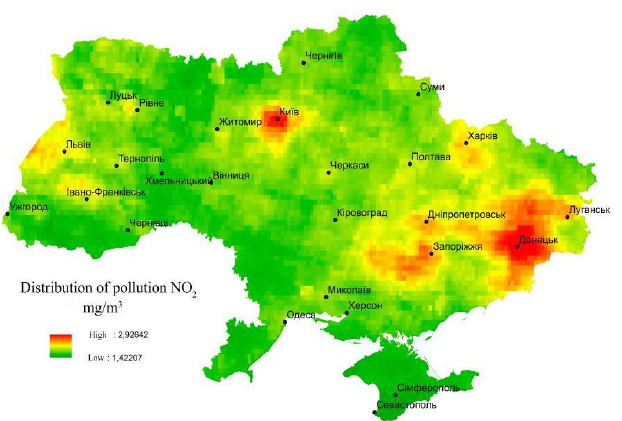
This regression equation helps to get corrected NO2 value for the whole territory. Practical implementation of calculation was performed using raster calculator tool, which is part of the module Spatial Analyst. The result of calculation is shown in Fig. 2.